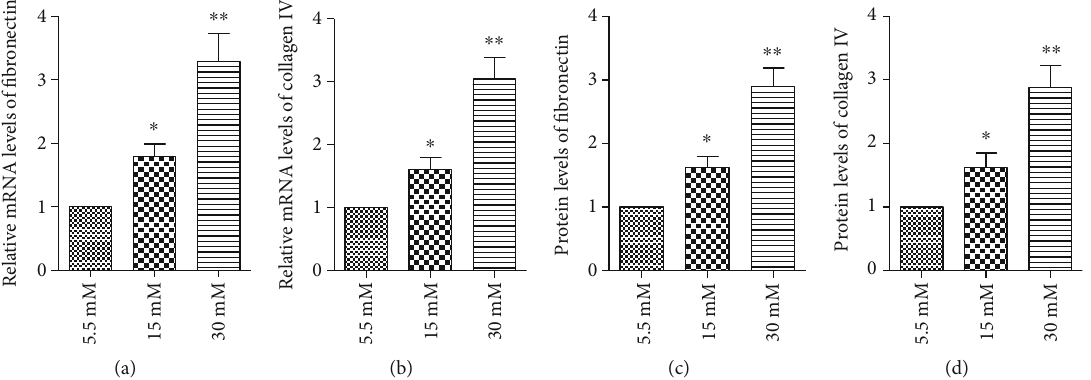
Figure 3: High glucose levels induced the expression of fi bronectin and collagen IV in RPE cells. Before measuring the expression of fi bronectin and collagen IV, the cells were exposed to normal glucose (5.5 mM) and high glucose (15 mM or 30 mM) for 24 h. A real-time PCR and an ELISA kit analysis illustrated that the (a, b) mRNA and (c, d) protein levels of fi bronectin and collagen IV were upregulated in response to high glucose compared with normal glucose. The data shown represent the mean ± standard deviation (SD) of three independent experiments. ∗ p < 0 : 05 versus 5.5 mM; ∗∗ p < 0 : 01 versus 5.5mM.